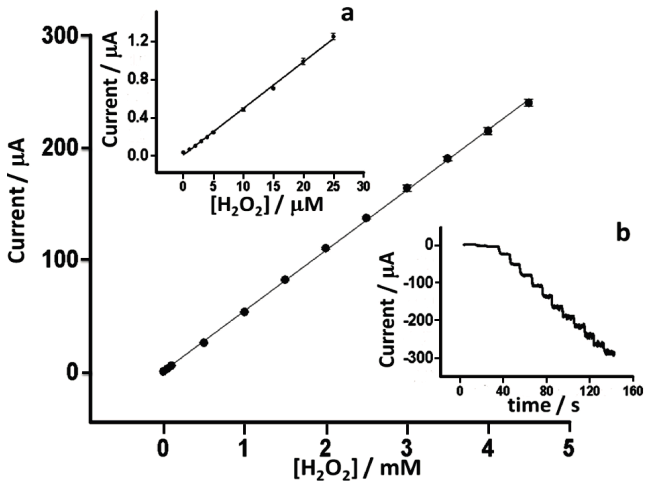
Figure 10. Calibration curve of H 0.1 M KCl, pH 7.4 at 0 V vs . Ag/AgCl. ( a ) Detail from 0 to 25 µM and ( b ) Raw amperometric data from 0 to 4.5 mM.